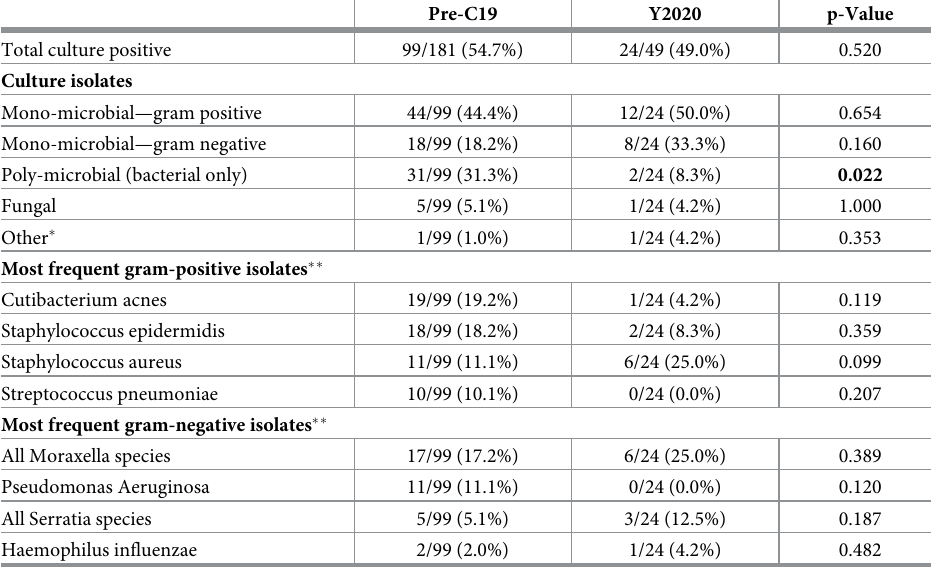
Table 4. Microbiology results